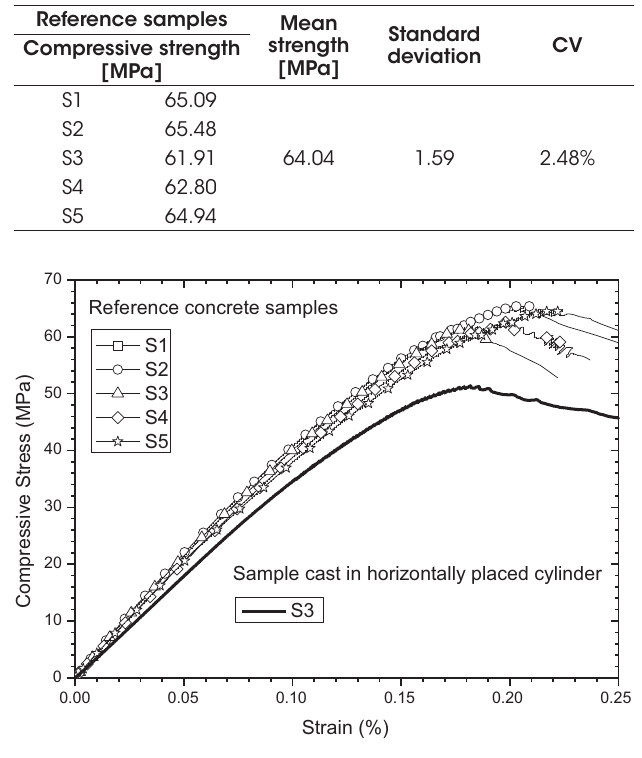
Compressive strength measured in conventional samples